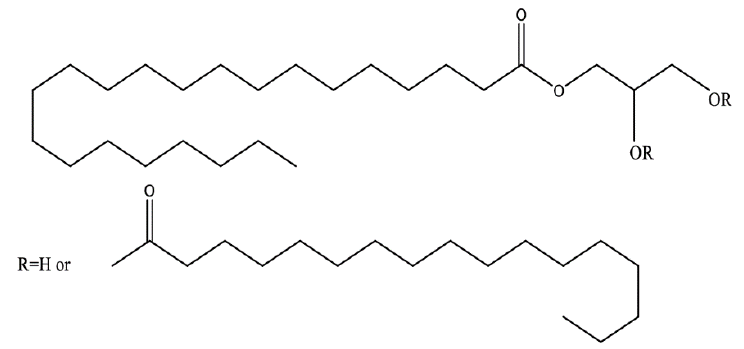
Figure 1. Chemical structure of Compritol 888 ATO.